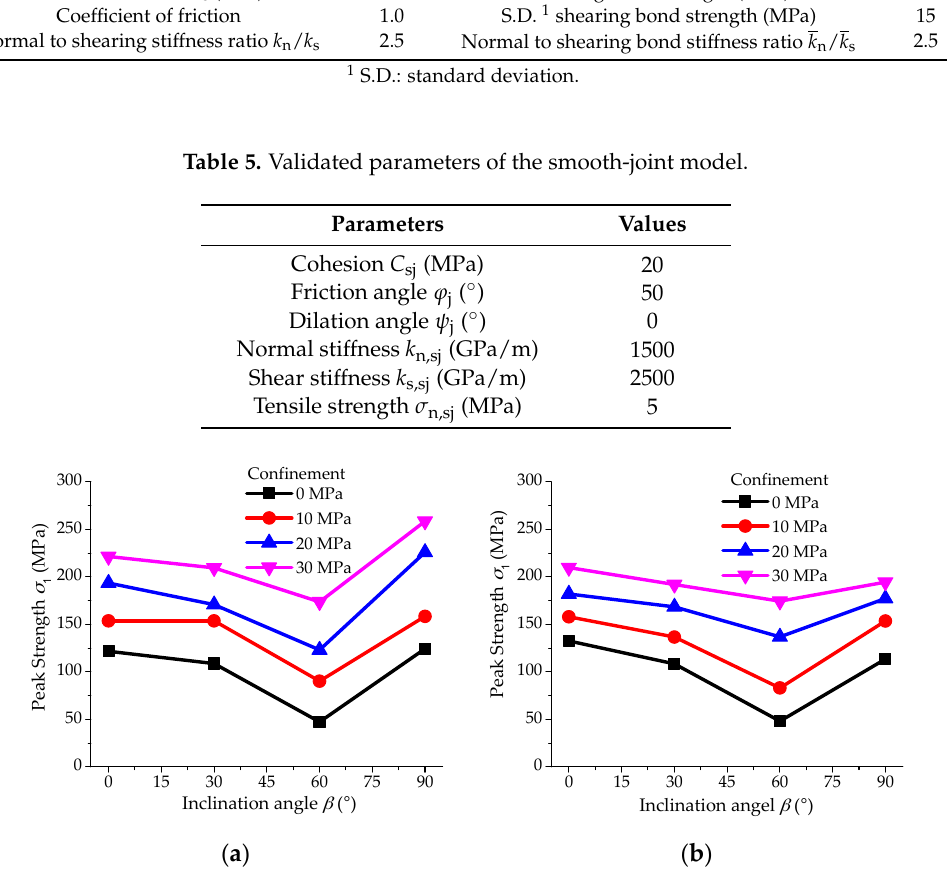
Figure 6. ( a ) The peak strength values of Shale-1 samples at different loading directions under various confinements [25]; and ( b ) the validated strength values of the numerical model.